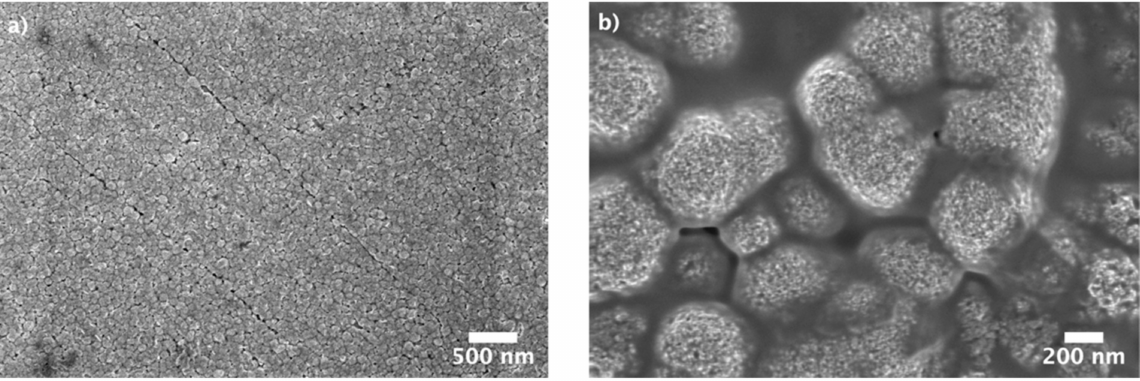
Figure 11. SEM images of surface-mesostructured films with composition ( a ) Cu 20 Ni 80 and ( b ) Cu 45 Ni 55 after 24 h durability